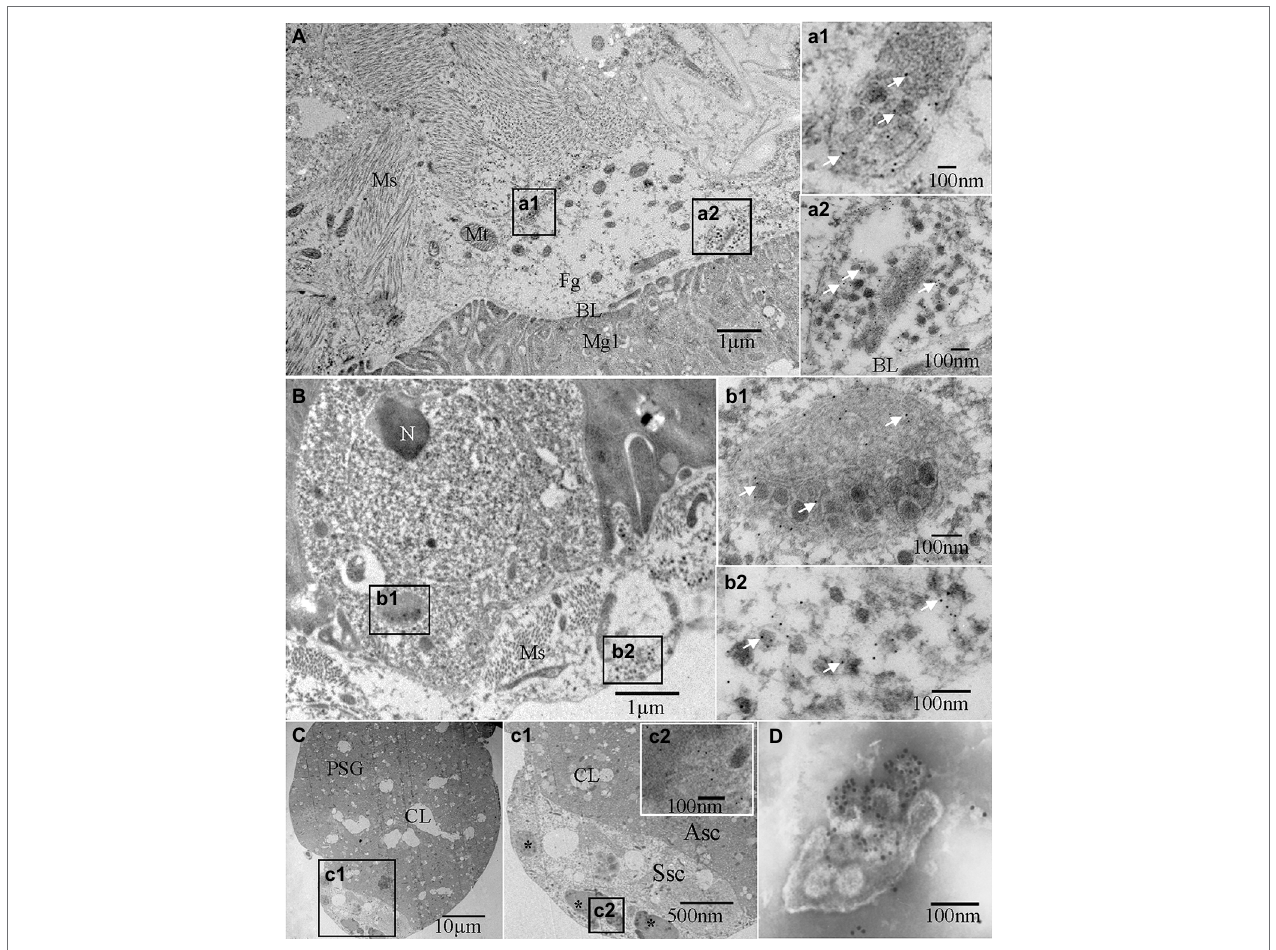
FIGURE 2 | Immunoelectron micrographs showing the subcellular distribution of TZSV particles and the TZSV nucleocapsid protein N (TZSV-N) in digestive systems of 2nd instar Frankliniella occidentalis nymphs at 72 h padp. Tissues were immunolabeled with TZSV-N-specific IgG as the primary antibody, followed by a specific secondary antibody that had been conjugated with 6-nm gold particles (white arrows). (A) Localization of viral particles in the foregut. (a1) and (a2) are enlargements of the boxed area in (A) , showing viral clustering in vesicles in the foregut; (a2) vesicle membrane fusing within the basal lamina between the foregut and midgut. (B) Epithelial cells and associated epitheliomuscular cells of the midgut. (b1) and (b2) are enlargements of the boxed area in (B) , showing details of the morphological characteristics and localization of viral particles and TZSV-N. (C) PSGs of F. occidentalis . (c1) is an enlargement of the boxed area in (C) , showing the characteristics of a senescent secretory cell and the localization of TZSV viroplasma (*); (c2) is an enlargement of the boxed area in (c1), showing gold particles on the electron-dense viroplasm matrix in a senescent secretory cell of the a PSG. (D) TZSV virion obtained from the sap of infected pepper leaves; 12-nm gold particles specifically labeled the TZSV particles. Asc: active secretory cell; BL: basal lamina; CL: cistern lumen; Fg: foregut; Hg: hindgut; Mg: midgut; Ms.: muscle; Mv: microvilli; N: nucleus; PSG: primary salivary gland; Ssc: senescent secretory cell; TSG: tubular salivary